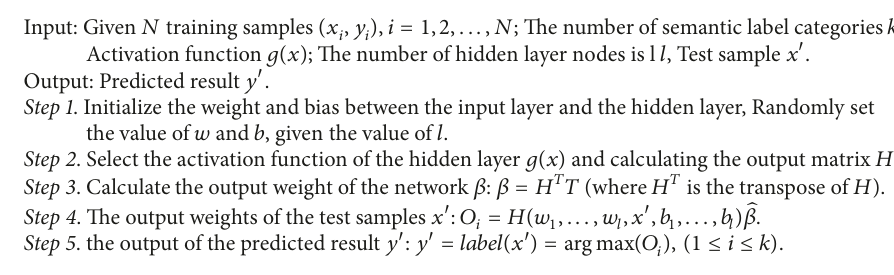
Algorithm 2: ELM classification algorithm.